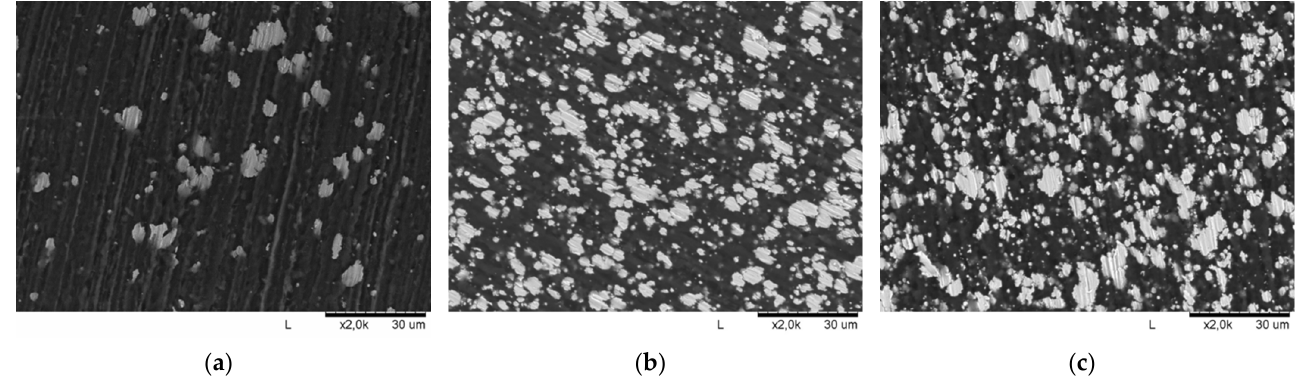
Figure 6. SEM images of the composite filaments: ( a ) PLA-Ni 5%; ( b ) PVB-Ni 25%; ( c ) ABS-Ni